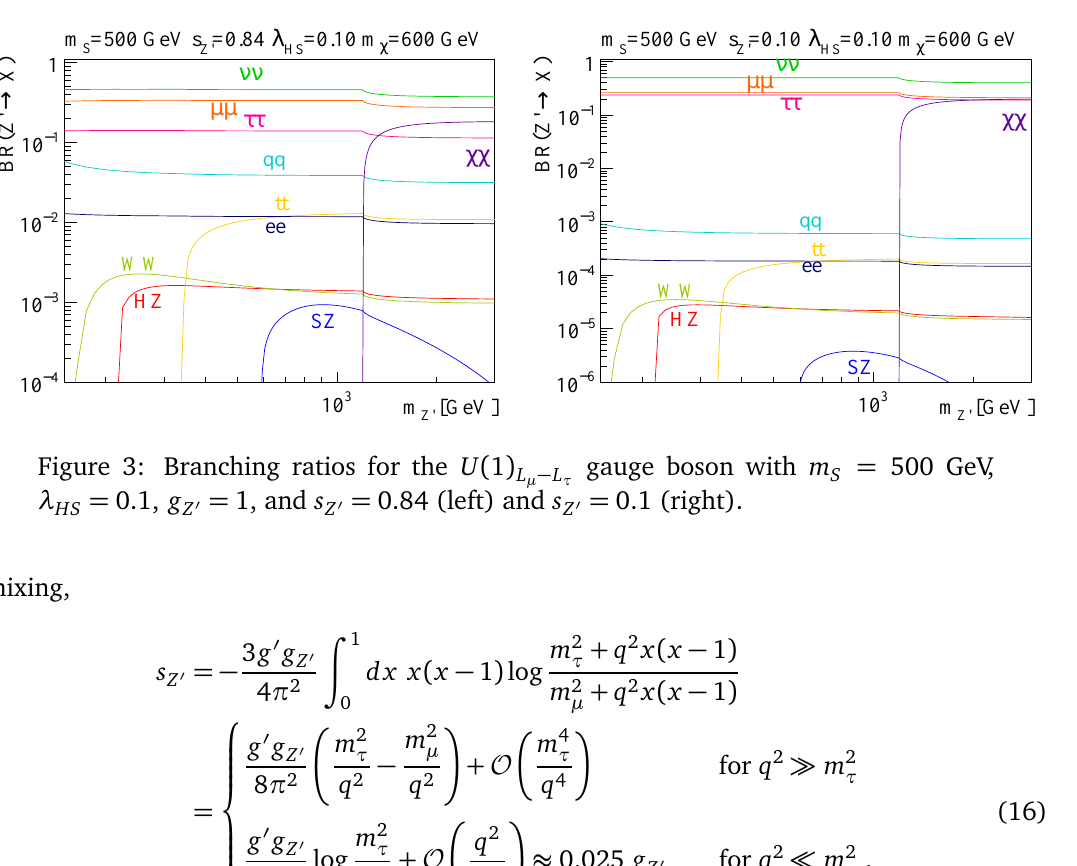
= 0.84 (left) and s Z (cid:48)